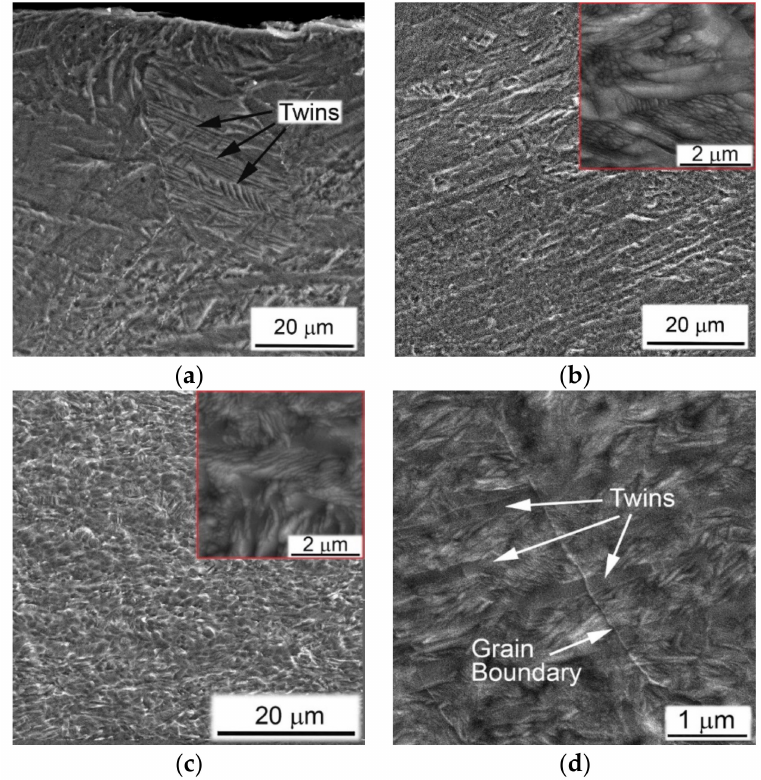
Figure 9. SEM images of c.p.Ti specimens sectioned along the longitudinal direction of the cylinders after: ( a , b ) SHPB test at the strain rate of 3200 s − 1 —( a ) near the zone I, ( b ) in the center of zone II; ( c , d ); quasi-static test with the strain rate 0.001 s − 1 —zone 4. SEM,